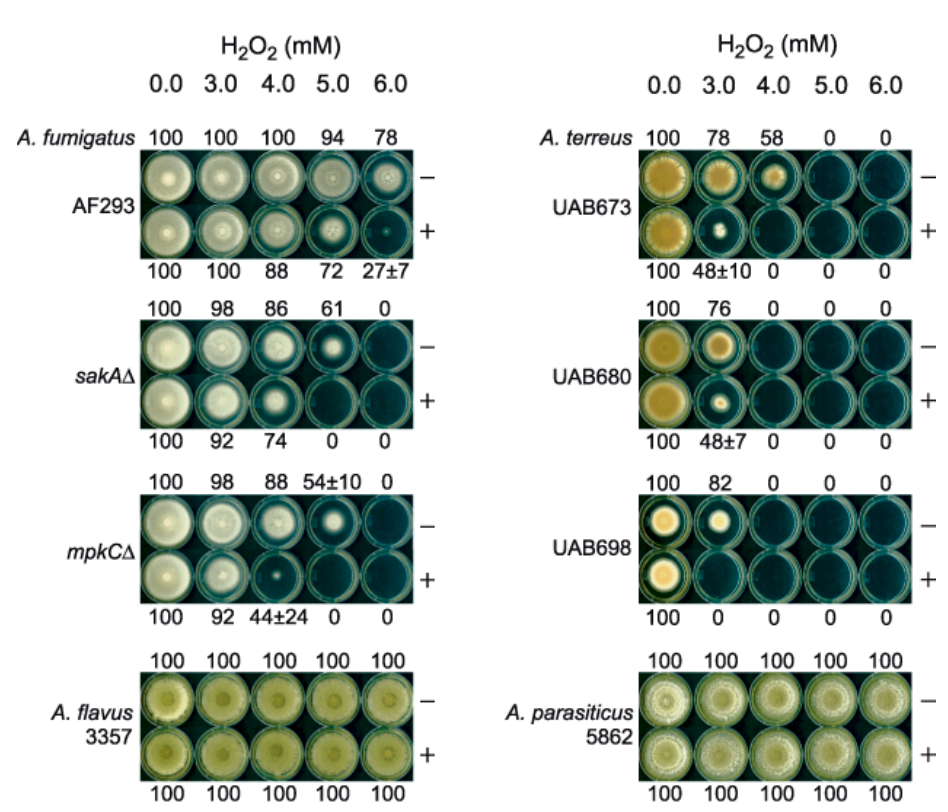
O and no KA). ( − ), w/o KA; 2 2